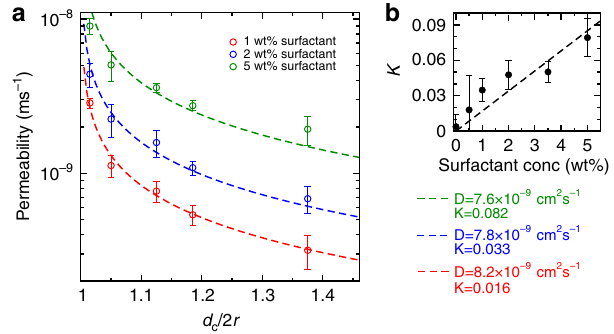
We compare the analytical expression equation 1 to our experimental results in Fig. 4. Qualitatively, the shape of the model curve fits the experimental data over the whole range of